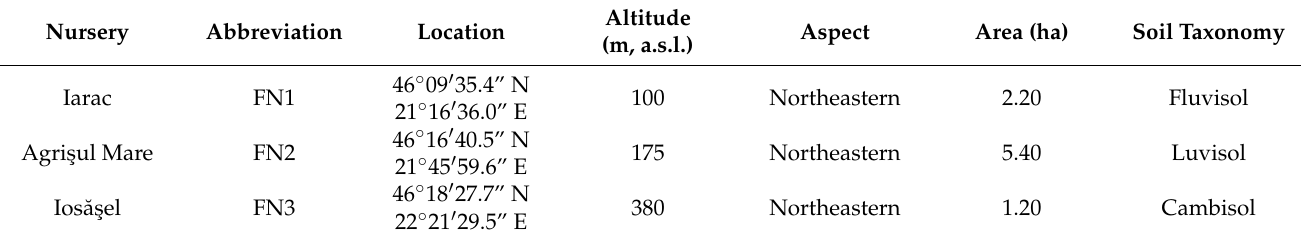
Table 1. Location of the forest nurseries and main description of the